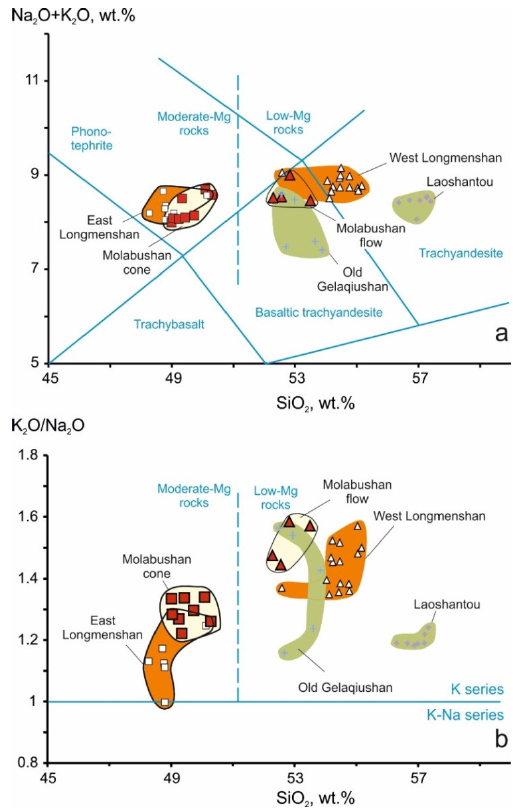
Figure 5. Variations of MgO versus SiO 2 in low- and moderate-Mg rocks from the Molabushan and Longmenshan volcanoes compared to those from older lava flows. The data used were from Table 2 and Tables S1. Anhydrous compositions were recalculated to 100%.